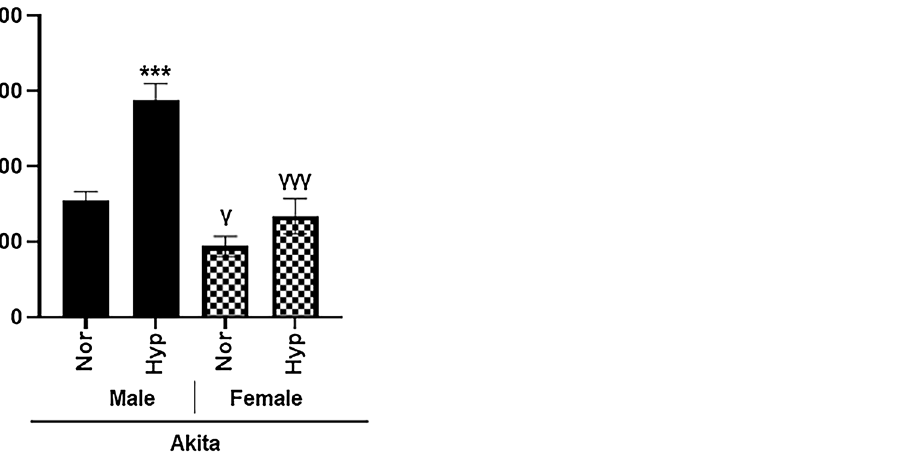
Figure 5. Dysregulation of serum estradiol in Akita male mice in both normal air and hyperoxia. Estradiol levels were measured in serum from normoxia and hyperoxia WT and Akita groups using ELISA kit. Error bars represent ± SEM. *p < 0.05, **p < 0.005 ***p < 0.0005. *compares effects of hyperoxia and normoxia of same gender and strain; Y compares male and female mice of the same strain and